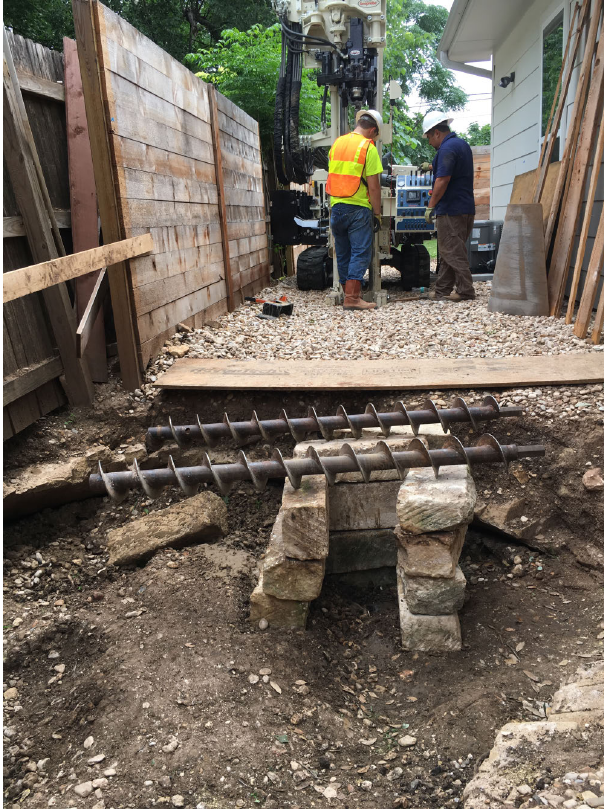
Figure 15: Picture showing the location of the cistern (old water well) and drilling at borehole location